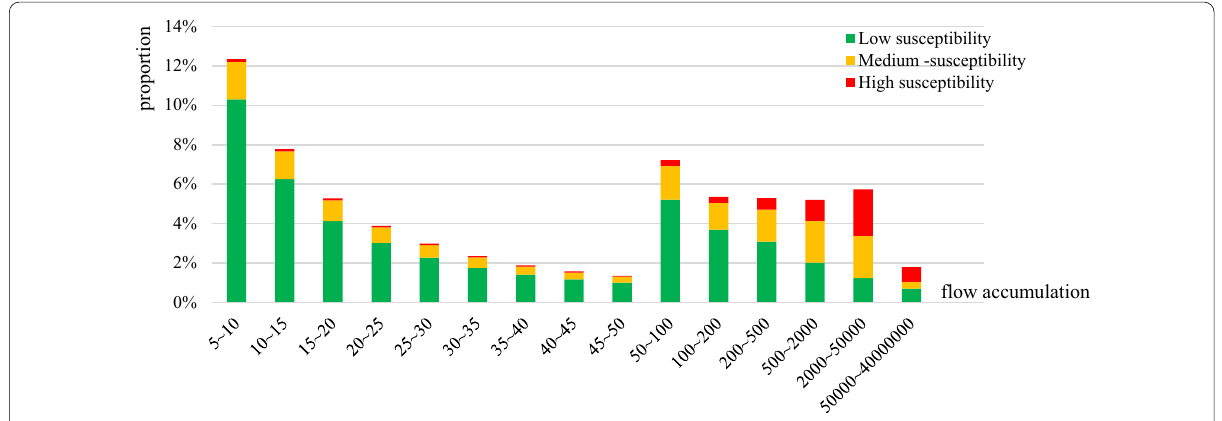
Fig. 12 Relationship between debris flow susceptibility and flow accumulation